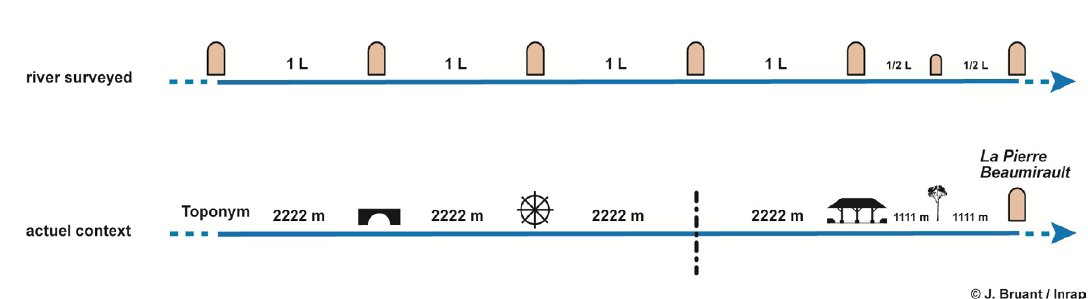
Fig. 16 - The map indicating the location of the Pierre Beaumirault : a leaguestone on a river system surveyed with the 2222 m metric.